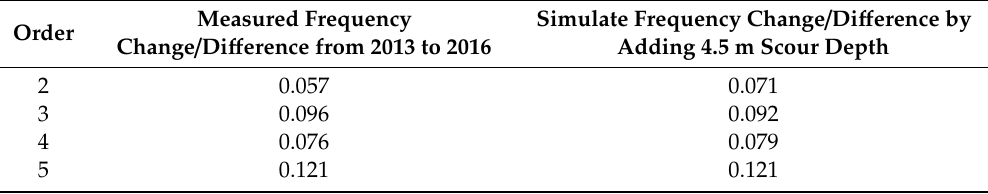
Table 9. Comparison between measured and simulated frequency changes.